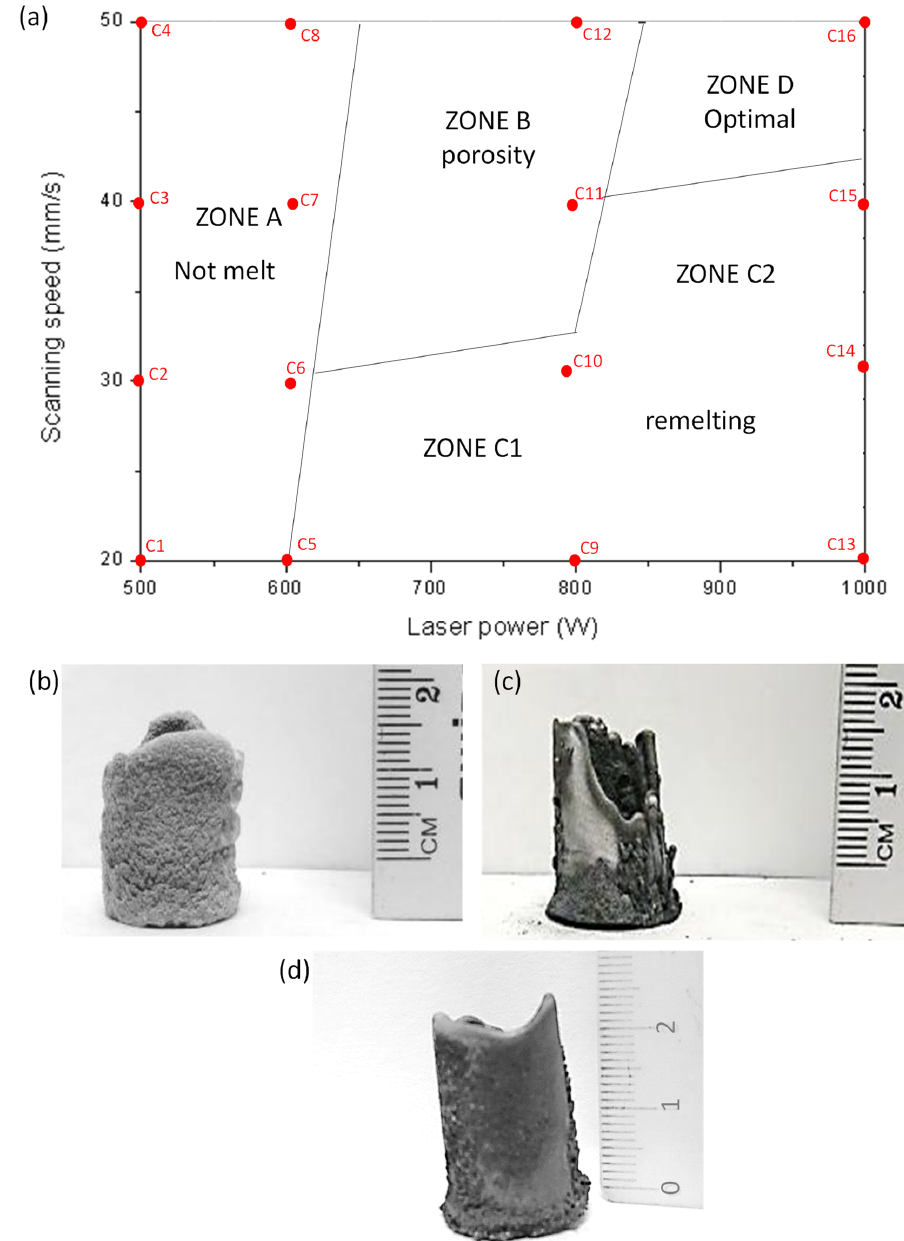
Figure 1. ( a ) Al / SiCp LMD process map; ( b ) sample morphology obtained in zone B; ( c ) sample Figure 1. ( a ) Al/SiCp LMD process map; ( b ) sample morphology obtained in zone B; ( c ) sample morphology obtained in zone D; ( d ) sample morphology obtained in zone morphology obtained in zone D; ( d ) sample morphology obtained in zone E.